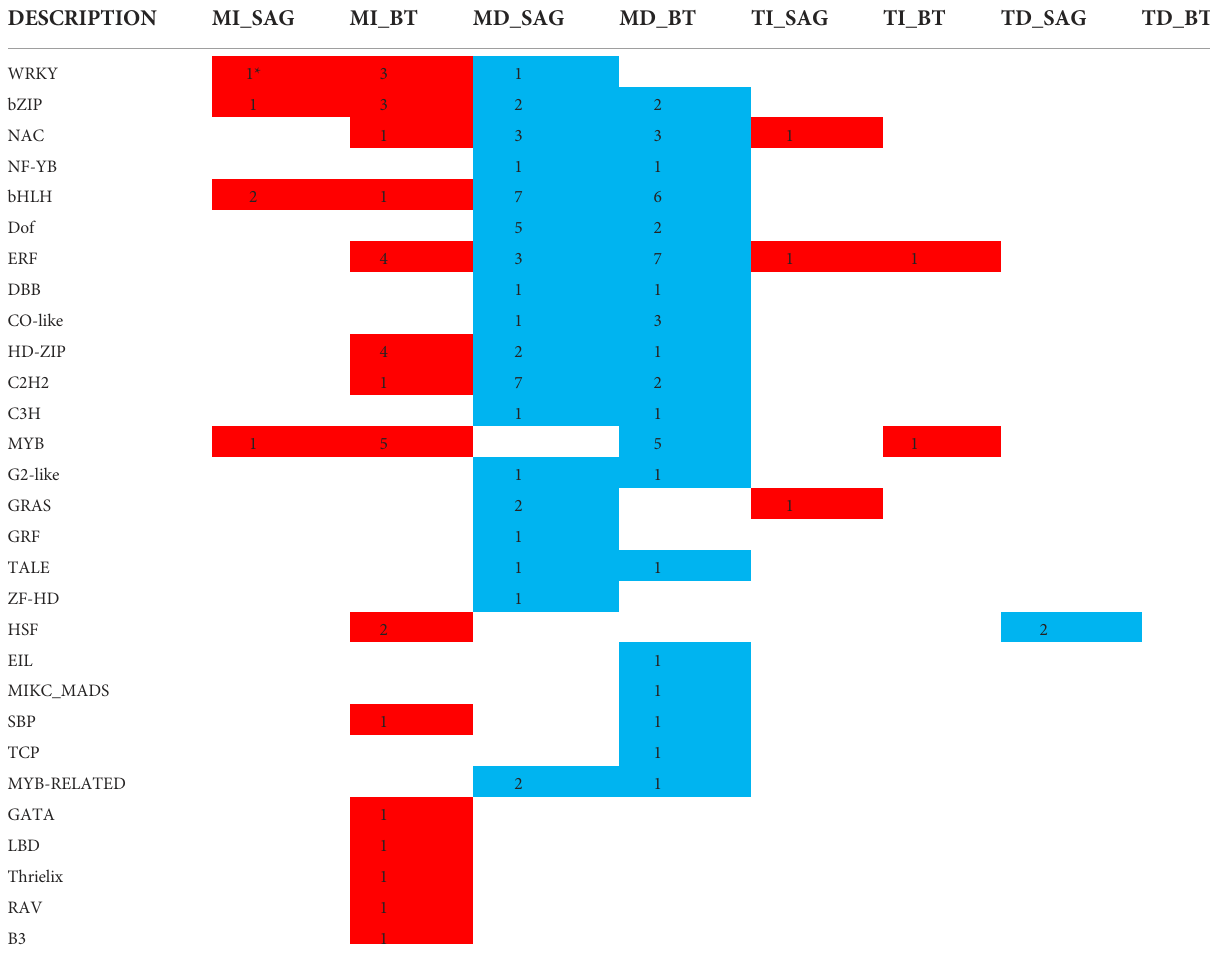
TABLE 5 Assignment of TF families to expression clusters.